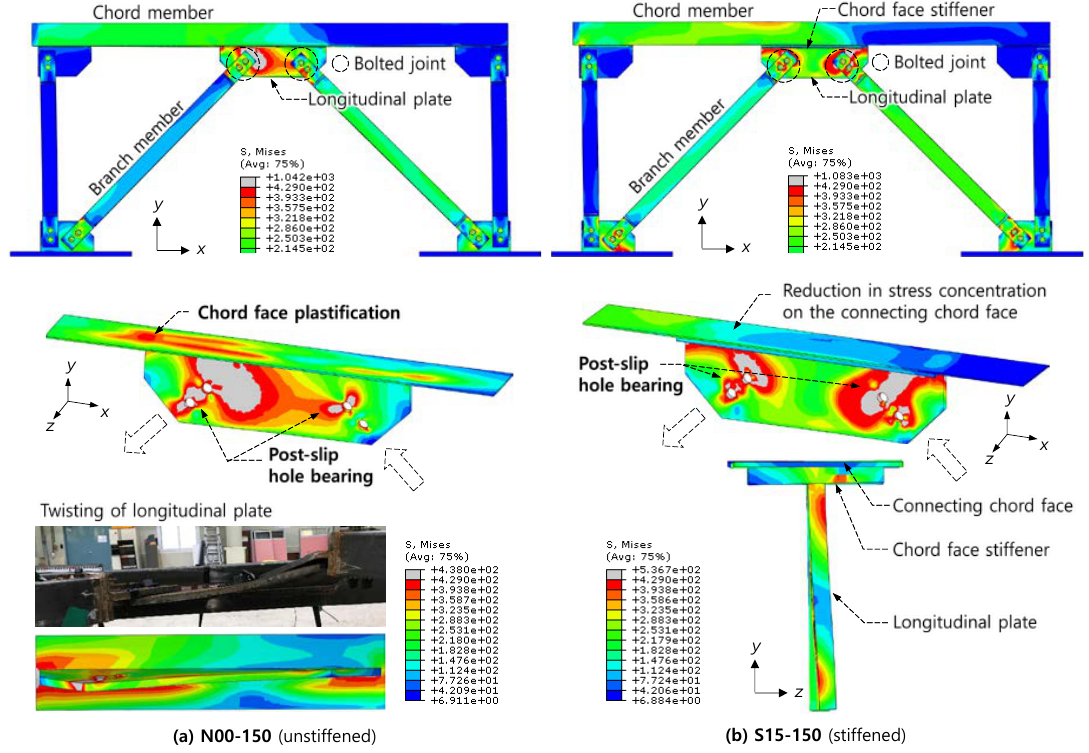
Figure 12. Results of FEM analysis: Mises stress contours and deformations at peak load points: ( a ) N00-150 (unstiffened); ( b ) S15-150 (stiffened).